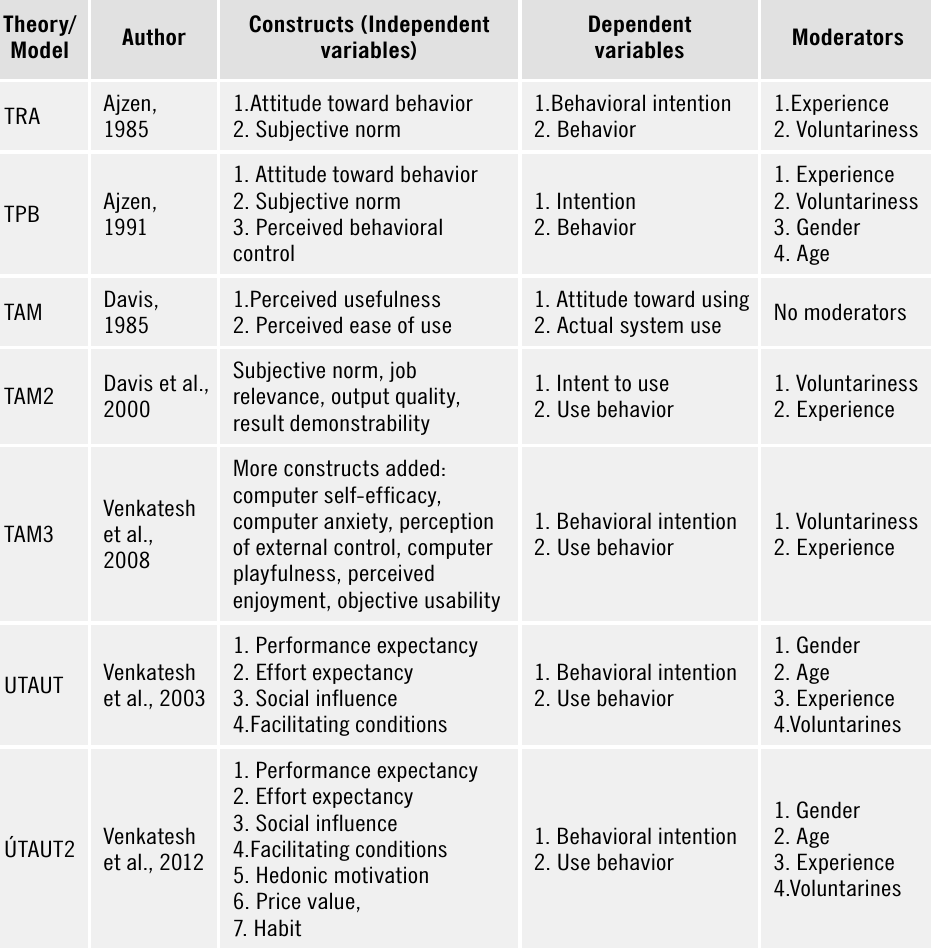
Table 1. Measurement structures of each